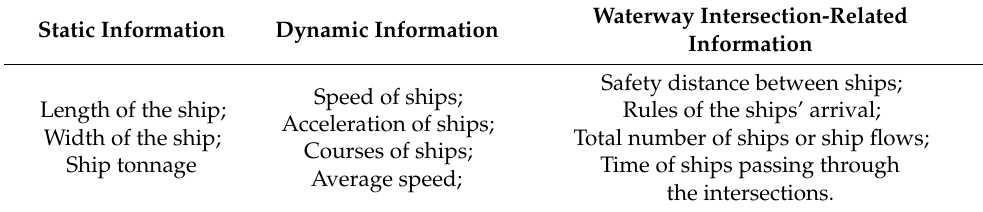
Table 6. Information in the intersection scheduling problems.